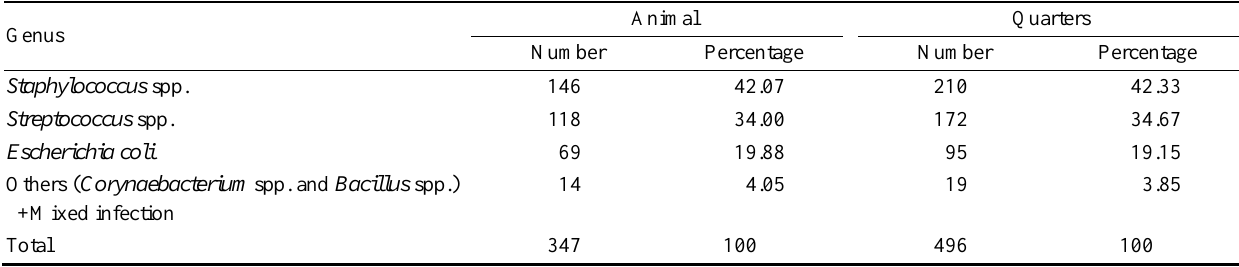
Animal Quarters Number Percentage Number Percentage